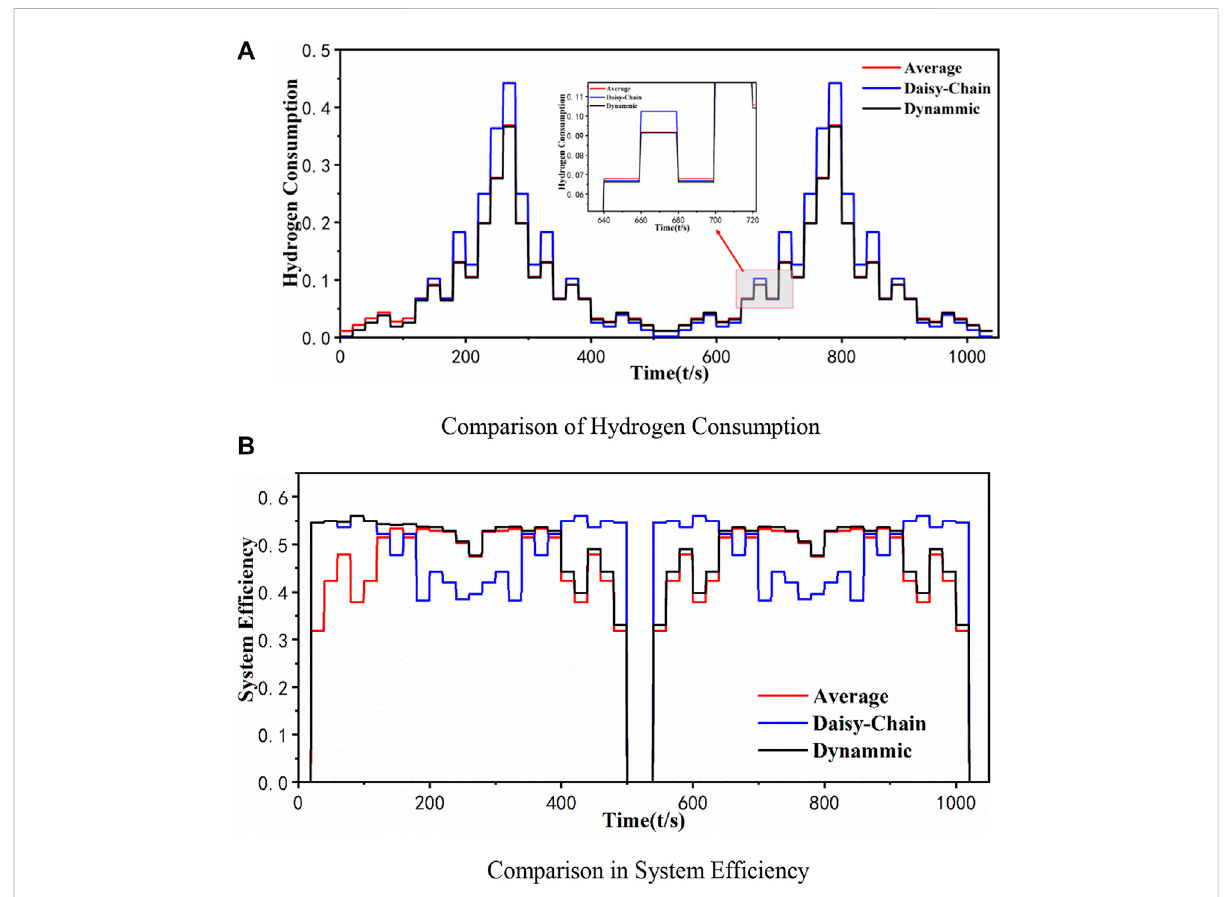
FIGURE 9 Comparison of different strategies. (A) Comparison of hydrogen consumption. (B) Comparison in system ef fi ciency.